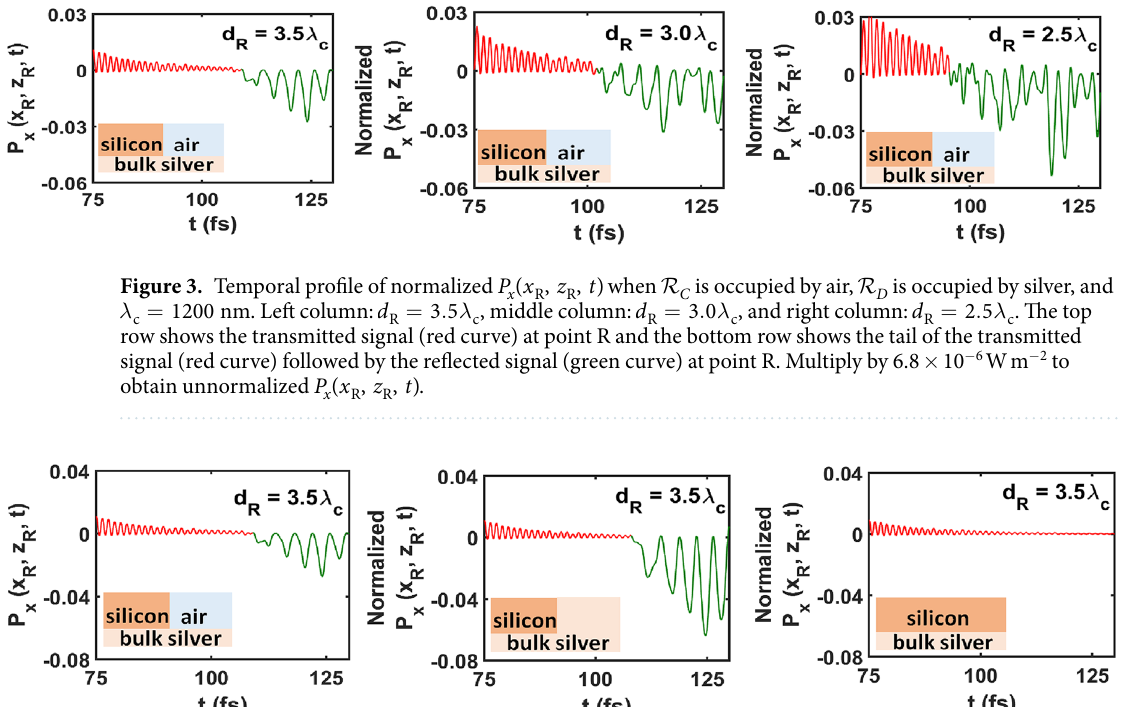
Figure 4. Temporal profile of normalized P x z t ( , , ) (left) air, (middle) silver, and (right) silicon; and  transmitted signal (red curve) followed by the reflected signal (green curve) at point R. Multiply by 6.8 × 10 − 6 W m − 2 to obtain unnormalized P x z t ( , , )